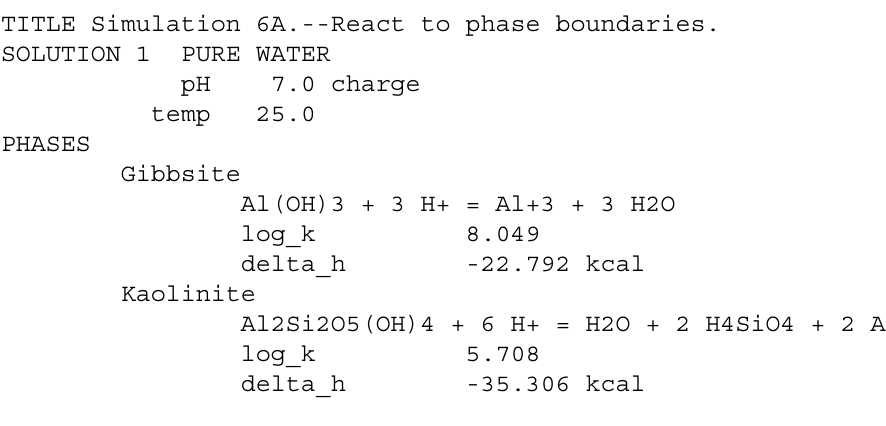
Table 21. Input file for example 6. TITLE Simulation 6A.--React to phase